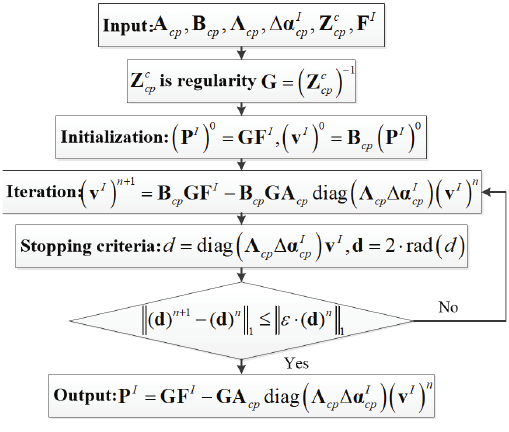
Figure 5. Flow chart of Rump’s inclusion